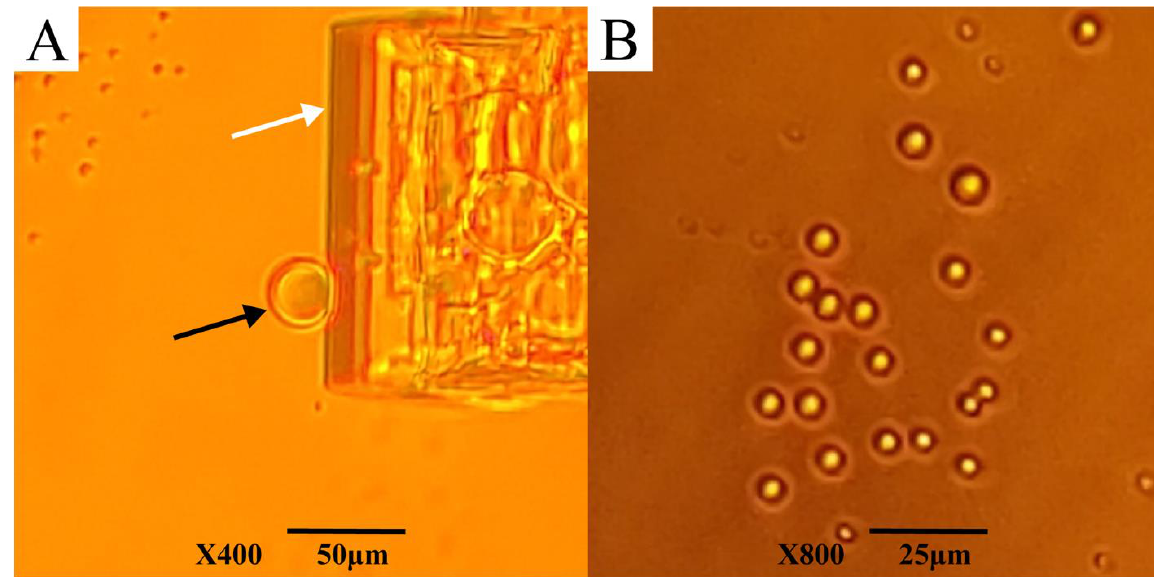
Figure 9. Af LEA1 undergoes LLPS during desiccation in vitro in a solution mimicking the intracellular conditions in A. franciscana . ( A ) When desiccated in the absence of RNA, Af LEA1 undergoes LLPS (black arrow) at severe dehydration concurrent with the formation of salt crystals in the solution (white arrow). ( B ) When desiccated in the presence of mRNA from A. franciscana, Af LEA1 rapidly undergoes LLPS at higher water contents than in an RNA-free solution and before salt crystals are formed.